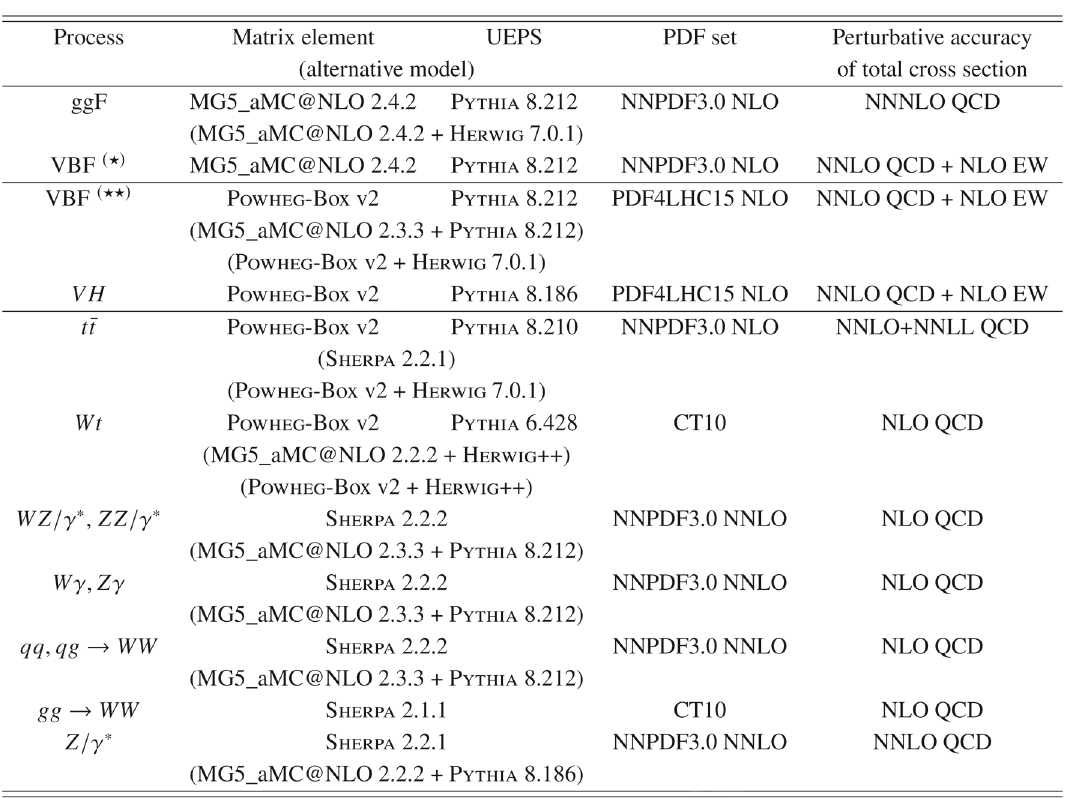
configurations marked with ((cid:2)(cid:2)) are used as background in the ggF